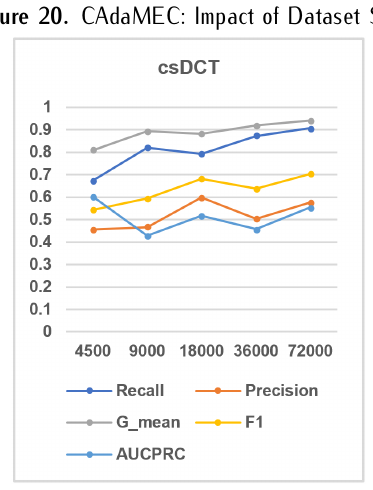
Figure 21. csDCT: Impact of Dataset Size